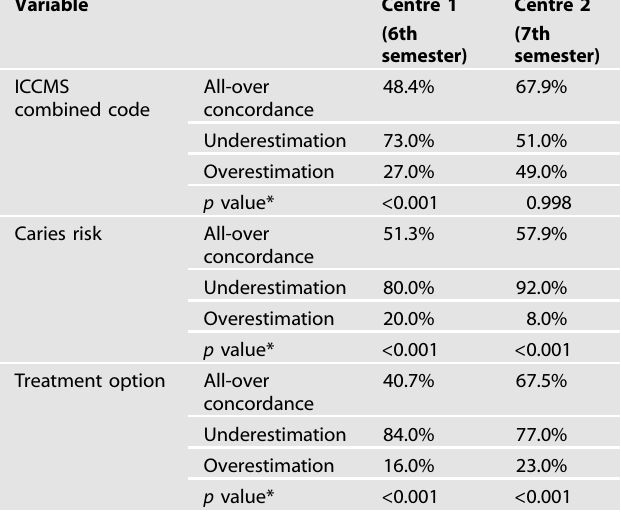
Table 1. Concordance between the students ’ performance and the reference standard and over- and underestimation of answers discordant with the reference.